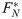
Effects of varying (a, c) risk of predation μ and (b, d) the cost of obesity κ on (a, b) the optimal strategy (dashed lines: FN*, solid lines: FG*) and (c, d) the various sources of mortality under normal conditions (starvation m
S, green lines; predation m
P, red lines; obesity m
B, blue lines), total mortality under normal conditions (dashed lines), and mortality from obesity in constant glut (solid lines).Note that the mortality from obesity under normal conditions is always very small and that at low κ mortality under constant glut conditions increases (to a small extent) as κ decreases. Baseline parameter values: γ = 10, ψ = 3, μ = 0.005, ϕ = 2, β = 3, κ = 0.01, ρ = 0.0001.